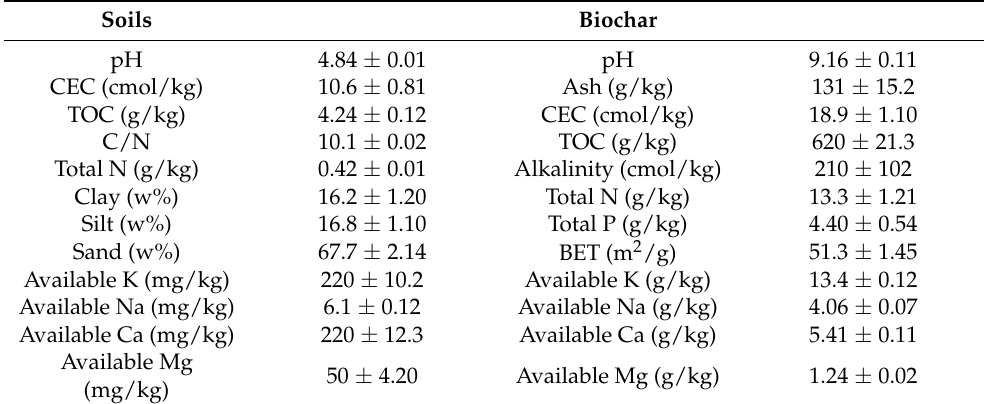
Table 1. Properties of the soil and biochar